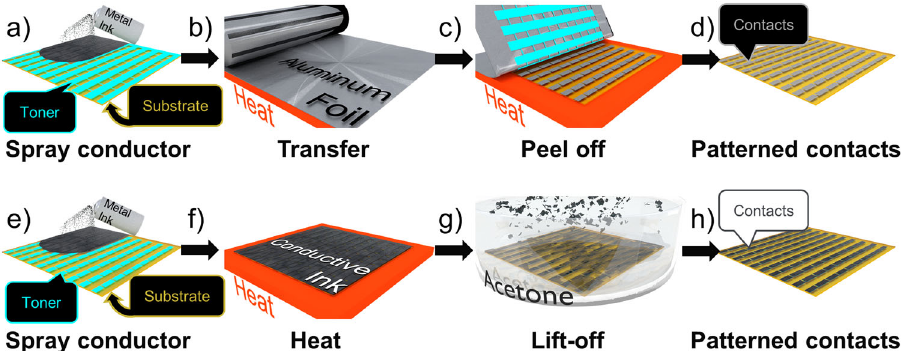
Fig. 1 Aerosol spray lithography process. a – d Negative lithography. a Print the negative pattern of the contacts with standard toner (shown here in cyan), then spray on layer of aerosol conductor (shown here as metal ink). b Heat substrate at 65 °C to cure the conductive layer; increase the temperature to 155 °C and apply pressure onto aluminum foil and roll with cylinder. c Remove aluminum foil while on hotplate at 155 °C. d Reveal contact pattern on dielectric material. e – h Positive lithography. e Print positive of contacts with standard toner (shown here in cyan), then spray on layer of aerosol conductor (shown here as metal ink). f Heat substrate at 65 °C to cure conductive layer. g Soak in acetone to release off-contact areas. h Reveal contact pattern